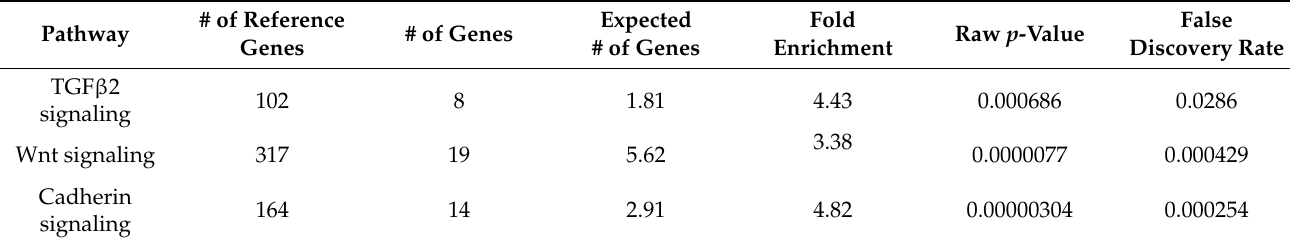
BMP4, SMAD6, TLL1, GDF15, INHBB, FOSL1 ); Wnt signaling ( WNT7B, WNT8B, ITPR2, MYCL, MYH15, PLCB1,